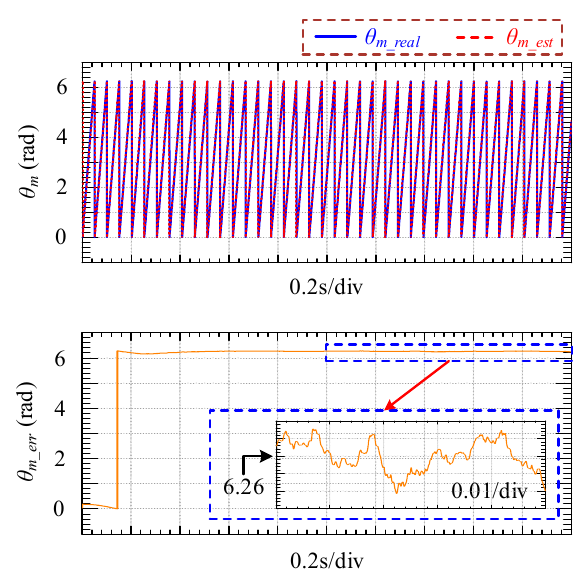
Figure 21. Real and estimated rotor positions with noises.